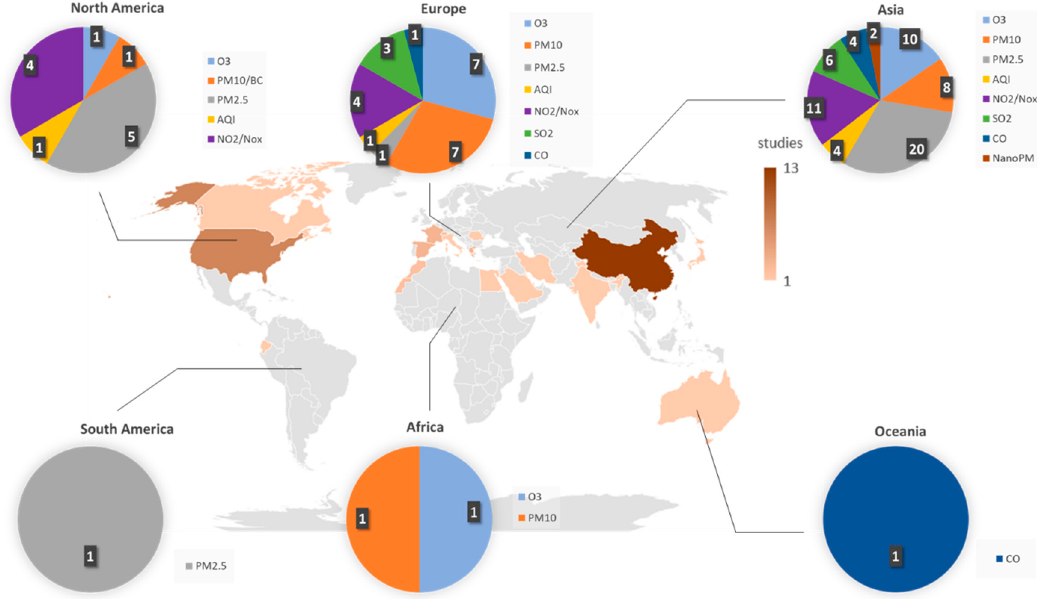
Figure 3. Number of papers per country and types of atmospheric contaminants studied by continent. The world map is colored by number of studies per country (yellow–brown), while the grey color indicates regions with no studies. The pollutant studies were considered per continent: O 3 —ozone, PM 10 —particulate matter with aerodynamic diameters ≤ 10 µm, BC—black carbon, PM 2.5 —particulate matter with aerodynamic diameters ≤ 2.5 µm, AQI—Air Quality Index, NO 2 —nitrogen dioxide, NO x — nitrogen oxides (NO + NO 2 ), SO 2 —sulfur dioxide, CO—carbon dioxide, NanoPM—nano particles (particles with diameter in nm).